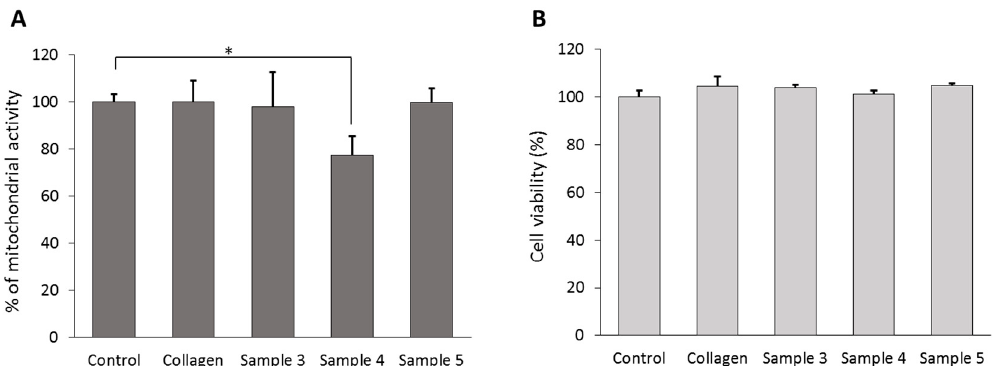
Figure 5. Viability of SHSY5Y cells after 48 h of growth on collagen films. ( A ) MTT assay data and ( B ) LDH assay results for human neuroblastoma cells cultured in normal growth conditions (plastic support) or on different collagen films. Error bars represent SEM. * p < 0.05 by Student’s t -test.